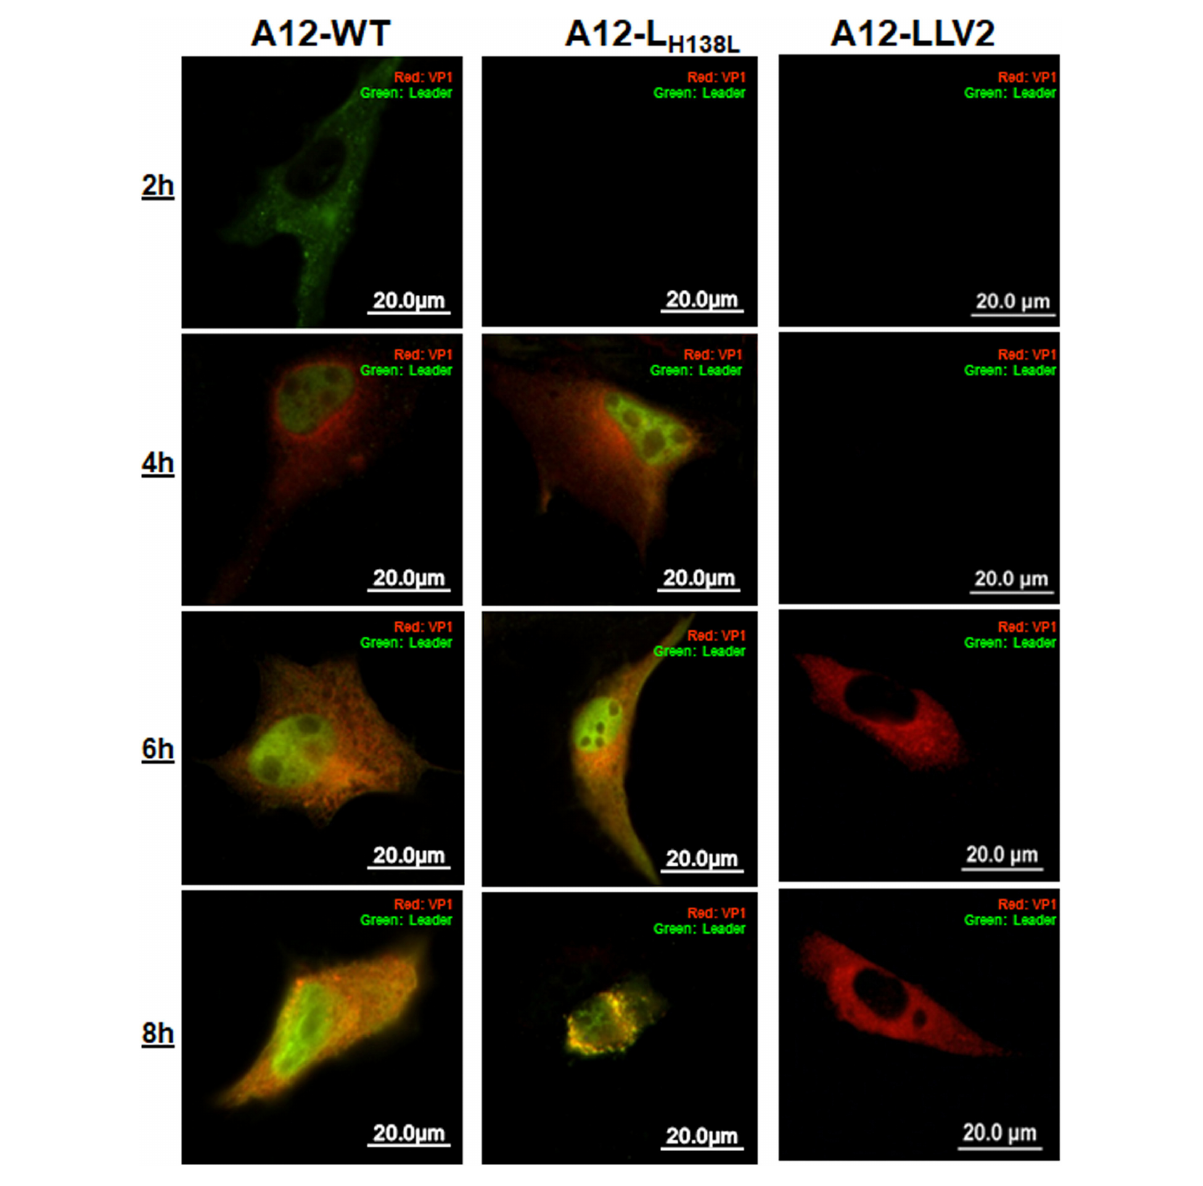
FIGURE4 Translocation of L pro is not affected in A12-L H138L. LF-BK cells were infected with A12-WT, A12-L H138L or A12-LLV FMDV at MOI = 10. At the indicated times cells were fixed and viral proteins L pro (green) and VP1 (red) were detected by IFA.